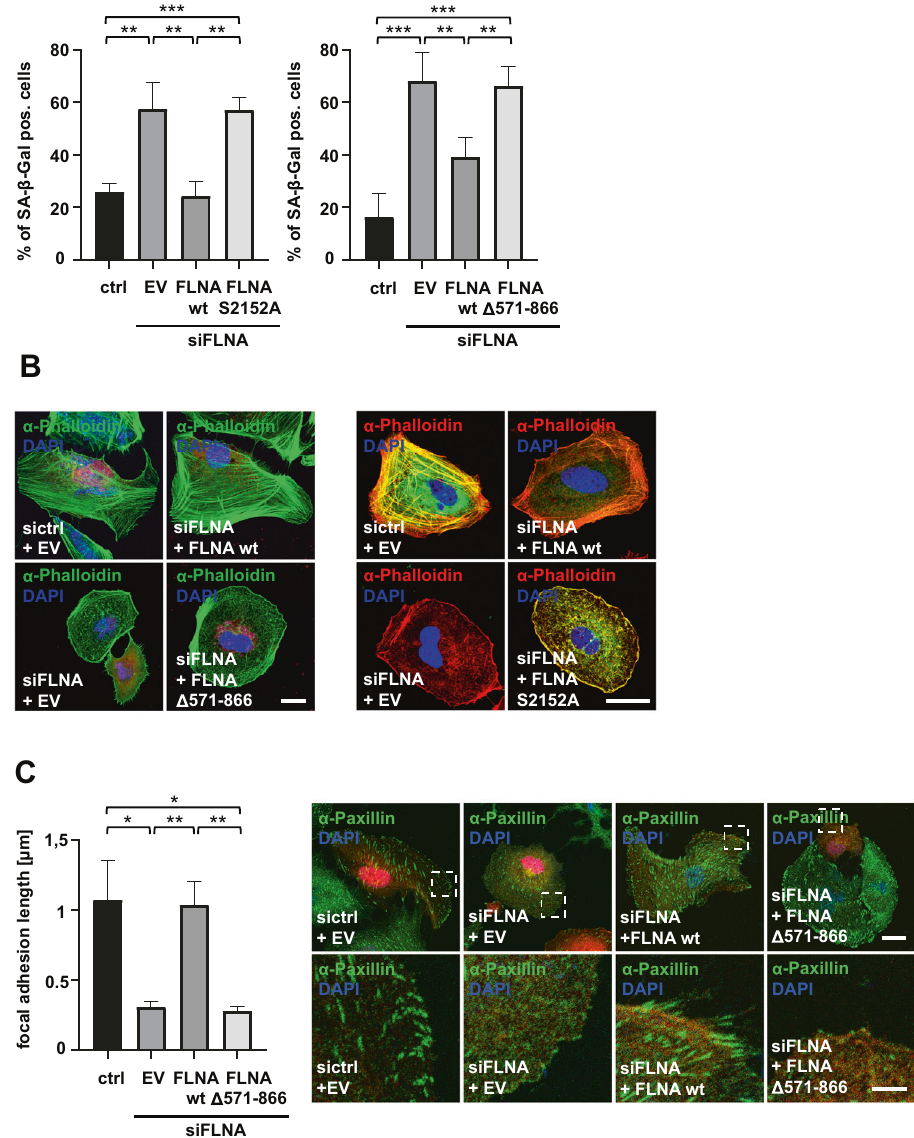
Fig. 6 LPAR1 modulates cellular senescence and cytoskeletal alterations in concert with FLNA. A Quanti fi cation of senescence-associated β -galactosidase (SA-ß-gal) staining in HuH7 cells expressing negative control siRNA (ctrl) or FLNA siRNA (siFLNA), Myc-FLNA wt, Myc-FLNA S2152A or Myc-empty vector (EV) (left) or mCherry-FLNA, mCherry-FLNA Δ 571-866 and – empty vector (EV) (right). A number of SA- β -gal positive blue cells was counted. Values are mean ± SD ( n = 3); ** p < 0.01, *** p < 0.001. B Immunostaining of F-actin by phalloidin in HuH7 cells transfected with scrambled siRNA (sictrl) or siFLNA and mCherry-FLNA (FLNA wt), mCherry-FLNA Δ 571 – 866 (FLNA Δ 571 – 866) or -empty vector (EV) (left) or FLNA siRNA (siFLNA), Myc-FLNA wt (FLNA wt), Myc-FLNA S2152A (FLNA S2152A) or -empty vector (EV) (right). DAPI was used for nuclei staining. Scale bar: 20 µm. C Quanti fi cation (left) of analysis of focal adhesion length by immunostaining (right) with anti- Paxillin antibody in HuH7 cells transfected with sictrl or siFLNA and mCherry-FLNA wt (FLNA wt), mCherry-FLNA Δ 571-866 (FLNA Δ 571 – 866) or -empty vector (EV). FLNA visualized in red. Scale bar: 20 µm. Values are mean ± SD ( n = 3); * p < 0.05, ** p <